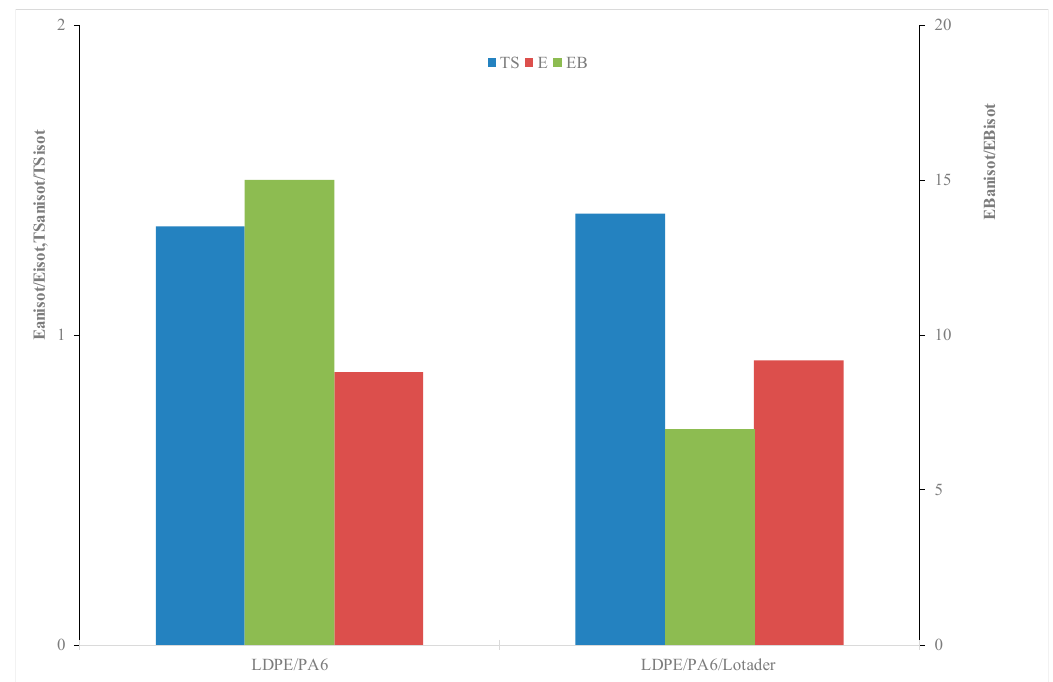
Figure 6. Dimensionless (anisotropic vs. isotropic) tensile properties of the investigated systems.